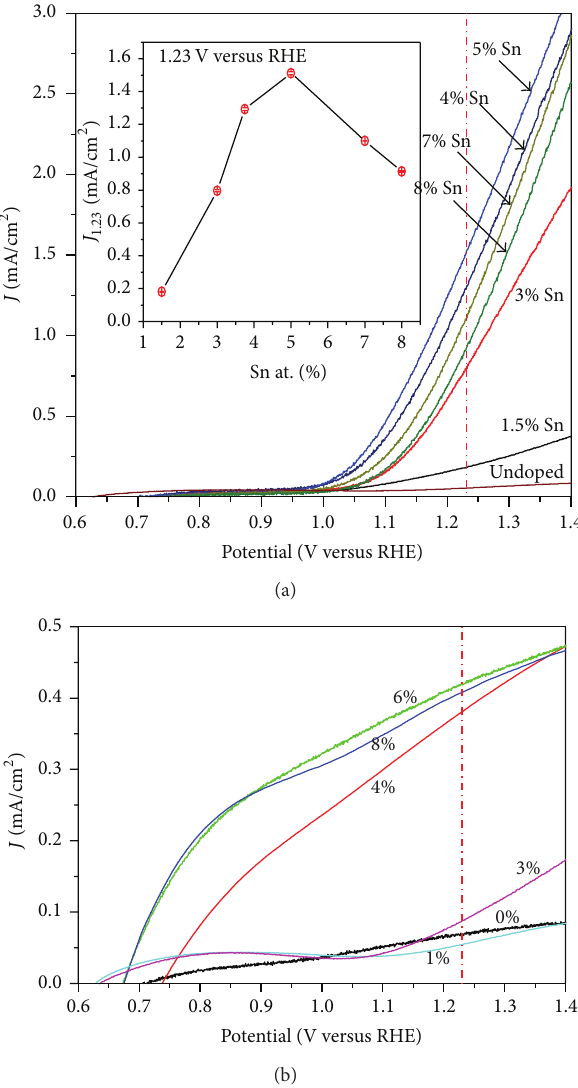
Figure 4: Photocurrent density versus bias potential of (a) Sn- (b) Ge-doped hematite photoanodes. All samples were measured in 1.0 M NaOH electrolyte under 300 W Xe lamp irradiation with an AM 1.5 filter. Inset of (a) the photocurrent density at 1.23V versus RHE as a function of Sn